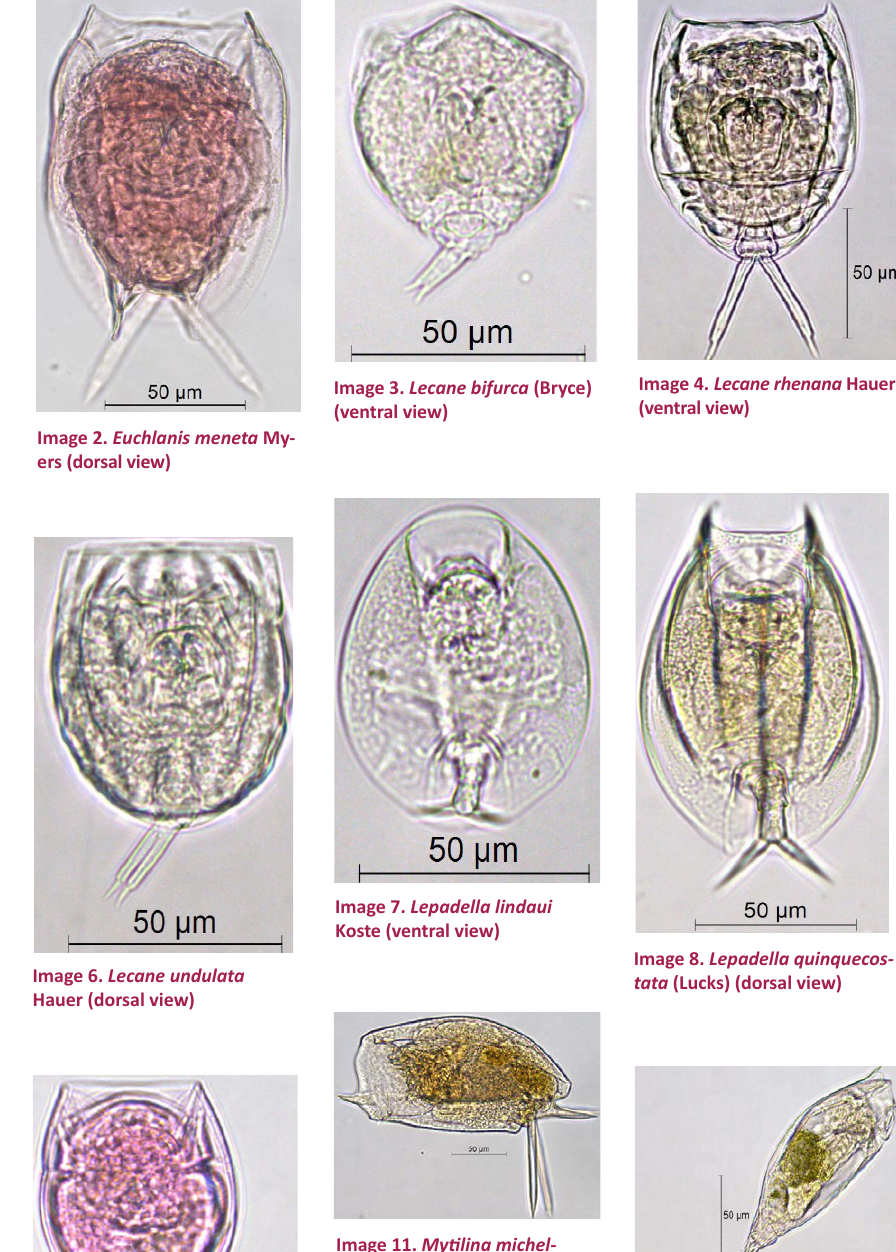
Image 11. Mytilina michel- angellii Reid & Turner (lateral view), after Sharma & Sharma (2014c)